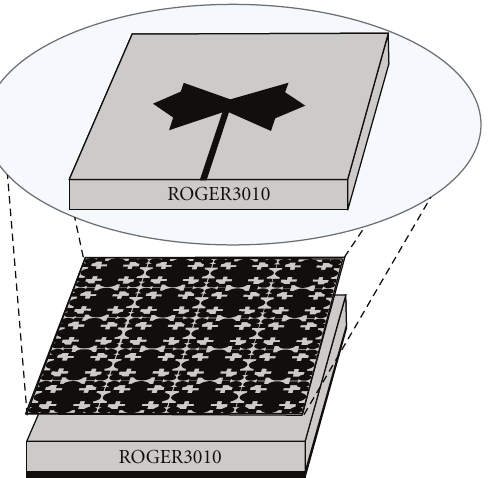
Figure 7: Measurement comparison between the prototypes: patch antenna, patch antenna-EBG, and patch